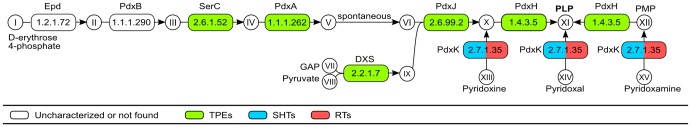
Biosynthesis of vitamin B6.
Metabolites - I: D-Erythrose 4-phosphate; II: 4-Phospho-D-erythronate; III: 2-Oxo-3-hydroxy-4-phosphobutanoate; IV: 4-phospho-hydroxy-L-threonine; V: 2-amino-3-oxo-4-phosphonooxybutyrate; VI: 3-Amino-2-oxopropyl phosphate; VII: D-glyceraldehyde 3-phosphate; VIII: pyruvate; IX: 1-deoxy-D-xylulose 5-phosphate; X: Pyridoxine phosphate; XI: Pyridoxal 5’-phosphate (PLP); XII: Pyridoxamine phosphate; XIII: Pyridoxine; XIV: Pyridoxal; XV: Pyridoxamine. Enzymes -
1.2.1.72: D-erythrose 4-phosphate dehydrogenase; 1.1.1.290: erythronate-4-phosphate dehydrogenase; 2.6.1.52: phosphoserine aminotransferase; 1.1.1.262: 4-hydroxythreonine-4-phosphate dehydrogenase; 2.2.1.7: 1-deoxyxylulose-5-phosphate synthase; 2.6.99.2: pyridoxine 5-phosphate synthase; 1.4.3.5: pyridoxamine 5'-phosphate oxidase; 2.7.1.35: pyridoxal kinase.